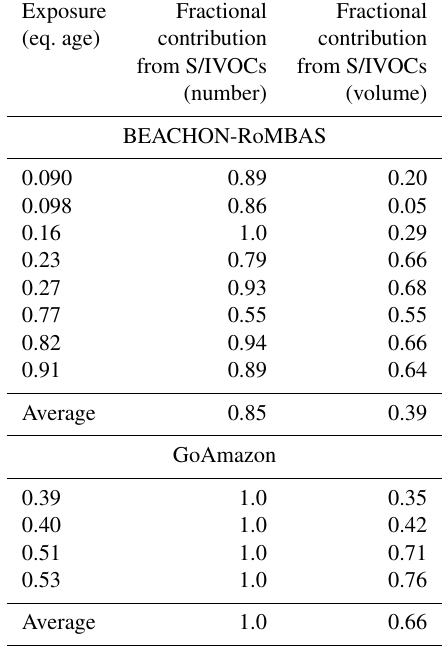
Table 4. Modeled fractional contribution of initial S/IVOCs towards the total change in number and volume between the initial and final number volume size distributions of each exposure modeled in this study. We use the measured S/IVOCs for the BEACHON-RoMBAS calculations and the best-fit initial S/IVOC concentration found for the GoAmazon calculations. The remaining fractional contribution towards the total change in number and volume is attributable to the measured initial monoterpenes (both campaigns) and measured ini- tial isoprene (GoAmazon). Each exposure’s fractional contribution is calculated using the averaged contributions of the six model cases with the lowest (best) NME values from the full model parameter